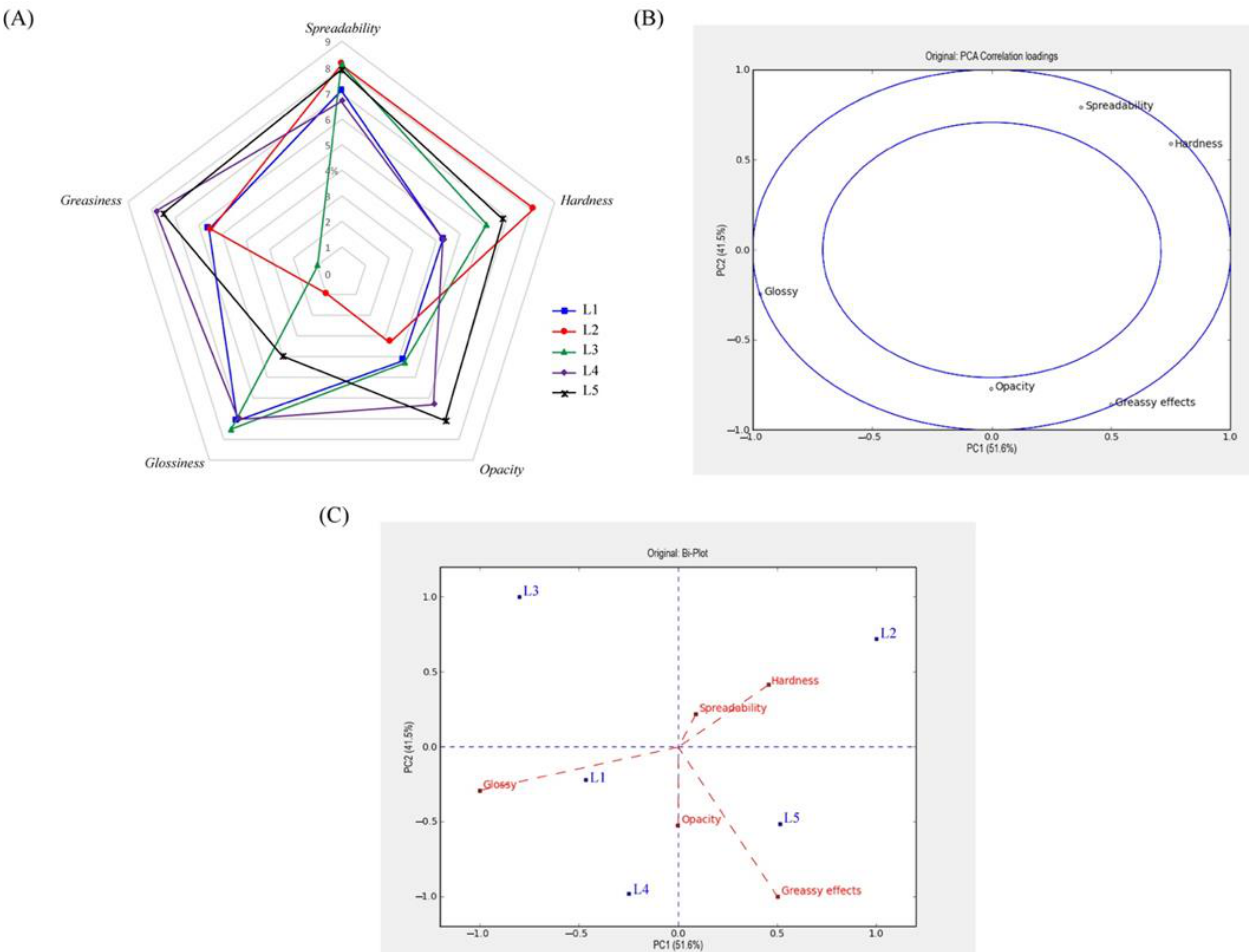
Figure 5. Sensory evaluation results of the produced and commercial lipsticks after application. Spider-plot ( A ), correlation loadings of the principal component analysis (PCA) for all the sensory attributes ( B ), and biplot representation of PCA illustrating relationship between attributes and formulations ( C ).